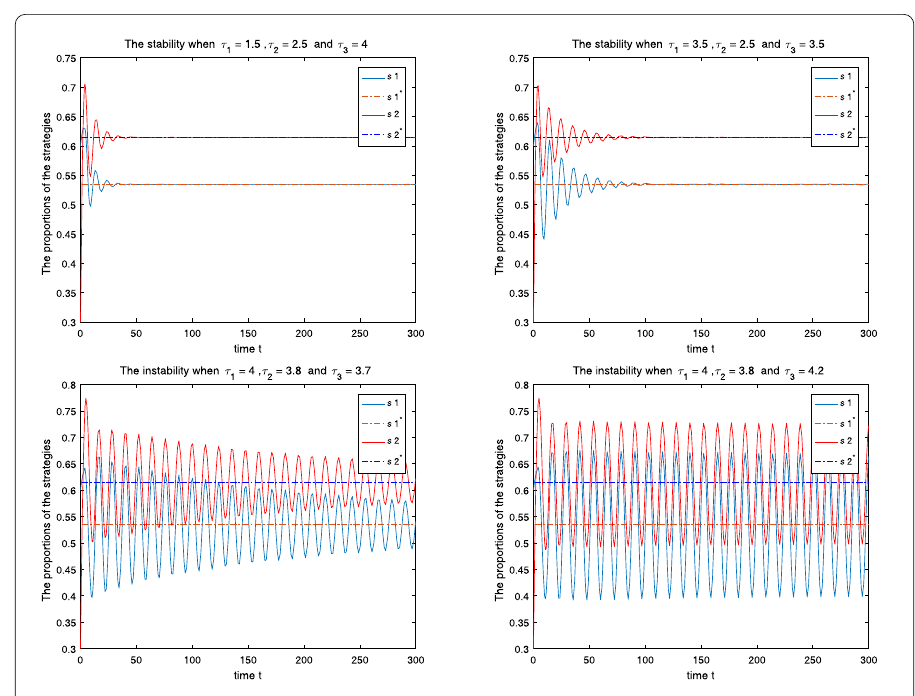
Figure 4 The stability and instability of the mixed NSS with three